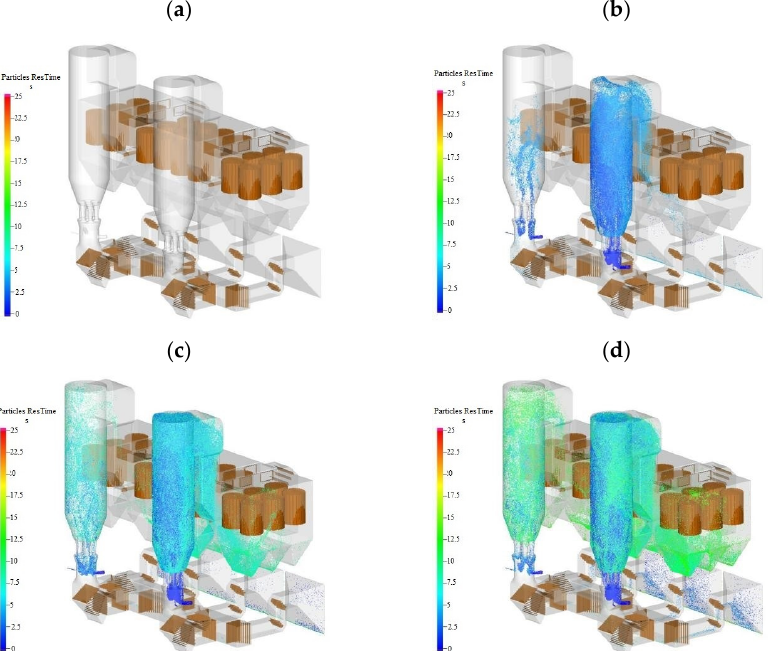
Figure 6. Particle distribution in towers at different times when single tower operation is switched to double tower operation; ( a ) t = 0 s ( b ) t = 5 s ( c ) t = 10 s ( d ) t = 15 s.